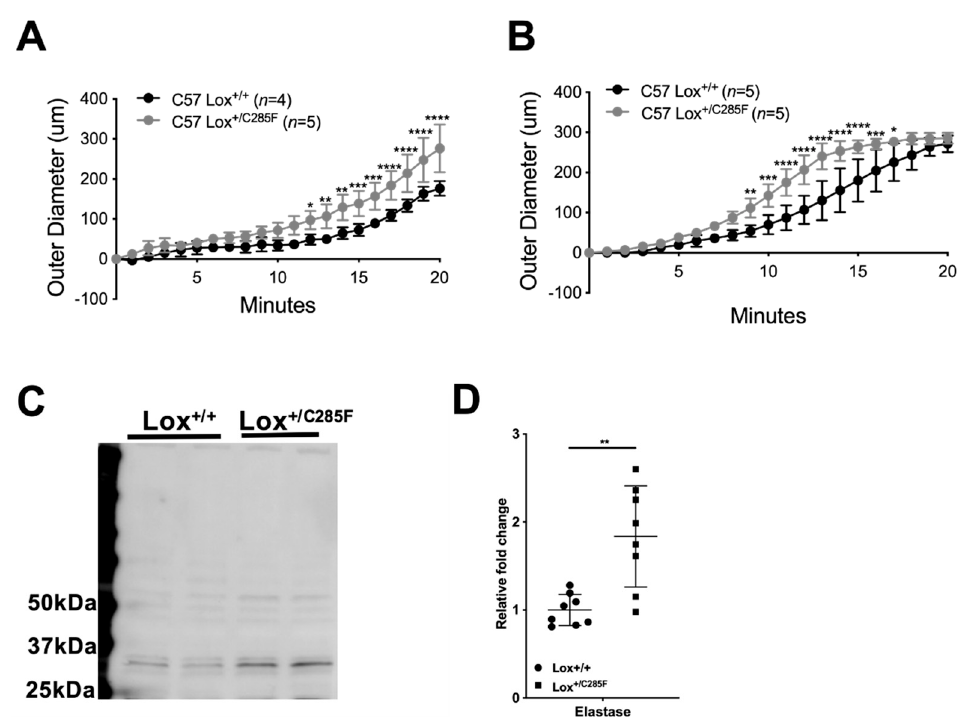
Figure 8. Elastin and collagen content in Lox +/C285F mice. ( A,B ), When bathed in porcine elastase and mechanically stressed, the Lox +/C285F ascending aorta ( A ) and left common carotid ( B ) arteries dilated at a faster rate than WT (( A , B ) by two-way ANOVA, Sidak). * p < 0.05; ** p < 0.01; *** p < 0.001; **** p < 0.0001. ( C ), Increased amount of elastase was seen in the aortas of Lox +/C285F mice, indicating the role of elastase in aortic dilation under Lox deficiency. ( D ), Graph shows the quantification of elastase of all measured samples using total protein as normalization. (Paired t -test) ** p < 0.01. Interestingly, we measured the endogenous elastase-1 protein level in aorta of 3- month-old HBP Lox +/C285F mutants and their counterparts using freshly prepared total protein lysate. Lox +/C285F aortas have more detectable Elastase-1 (Figure 8C, n = 8/group) (quantified in Figure 8D, p < 0.01 in Lox +/C285F vs. Lox +/+ ).